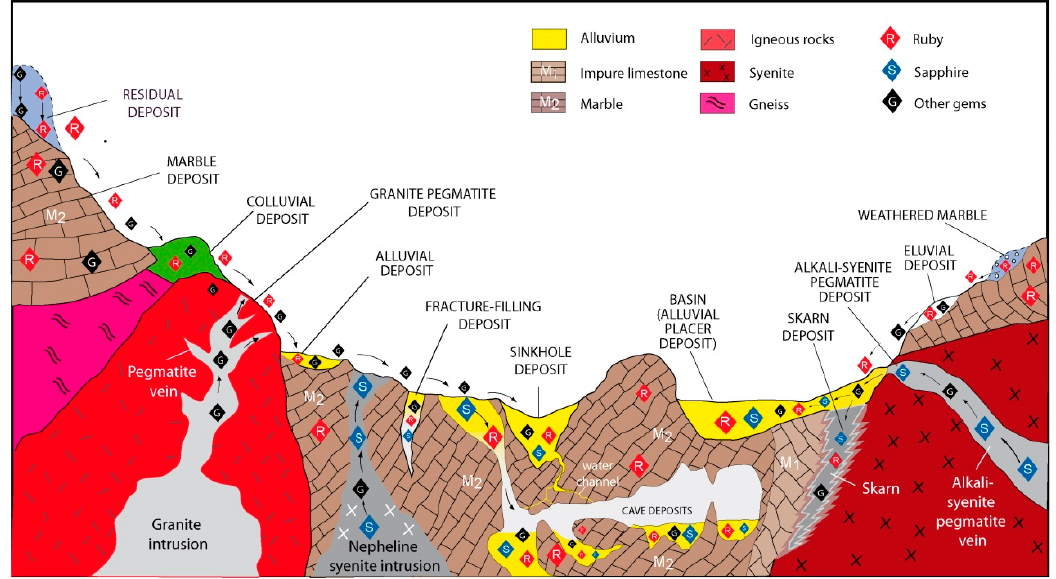
Figure 57. The main types of ruby-bearing placers in the Mogok Stone Track, Myanmar; modified from [29]. The primary ruby deposits are located in marble and the secondary deposits are residual, colluvial, alluvial, fracture-filling, and cave placers in karst morphologies. The figure represents the ruby deposit of Dattaw in marble (on the left) and the sapphire deposit of Thurein-taung (on the right). At Mogok, the different types of primary deposits of ruby and sapphires resulted in the mingling of gems from different sources in single secondary accumulations.